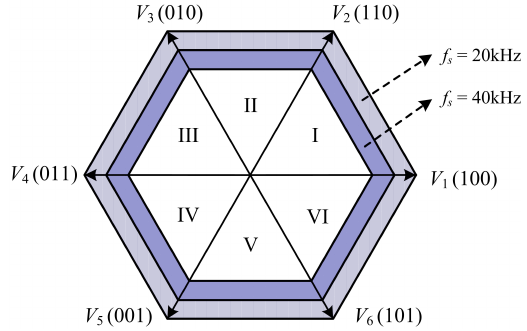
Figure 7. The reconstruction dead zones of the novel phase current reconstruction